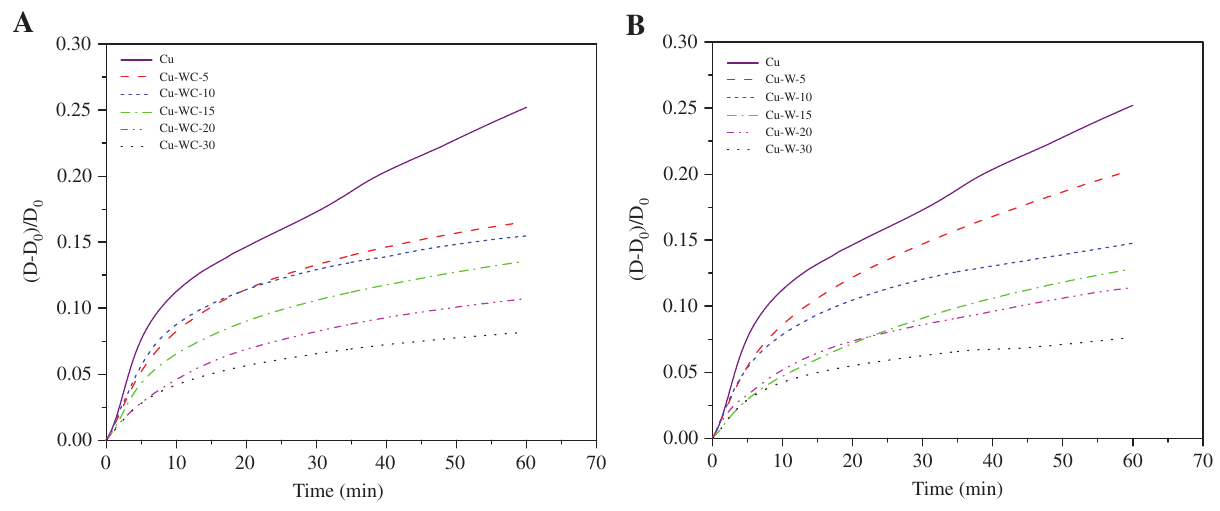
Figure 3: Isothermal densification as a function of the time during the sintering plateau: (A) Cu-WC and (B)